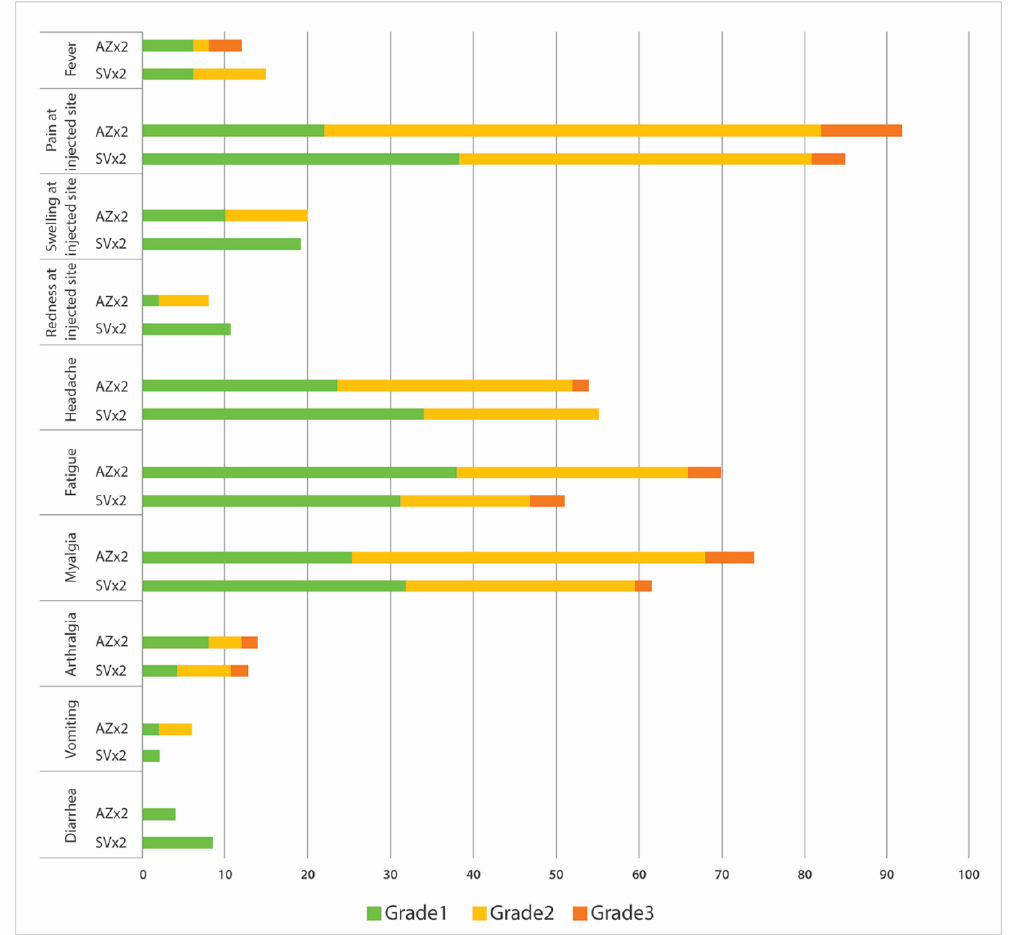
Figure 2. CoronaVac-primed individuals experienced local and systemic reactogenicity similar to AZD1222-primed individuals.